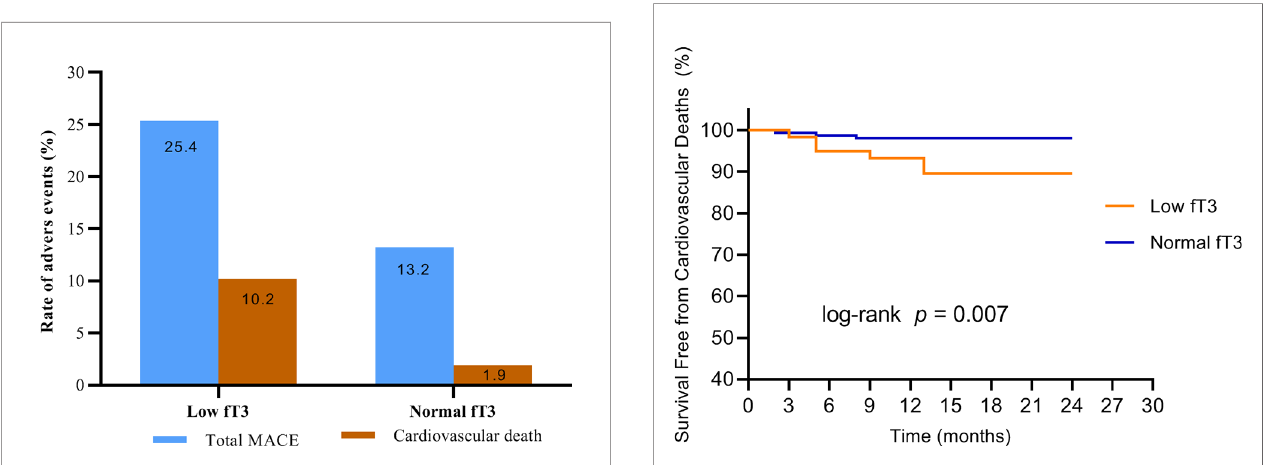
FIGURE 1 | Rate of adverse events in MINOCA patients with low fT3 versus normal fT3 levels. fT3, free triiodothyronine; MACE, major adverse cardiovascular events.